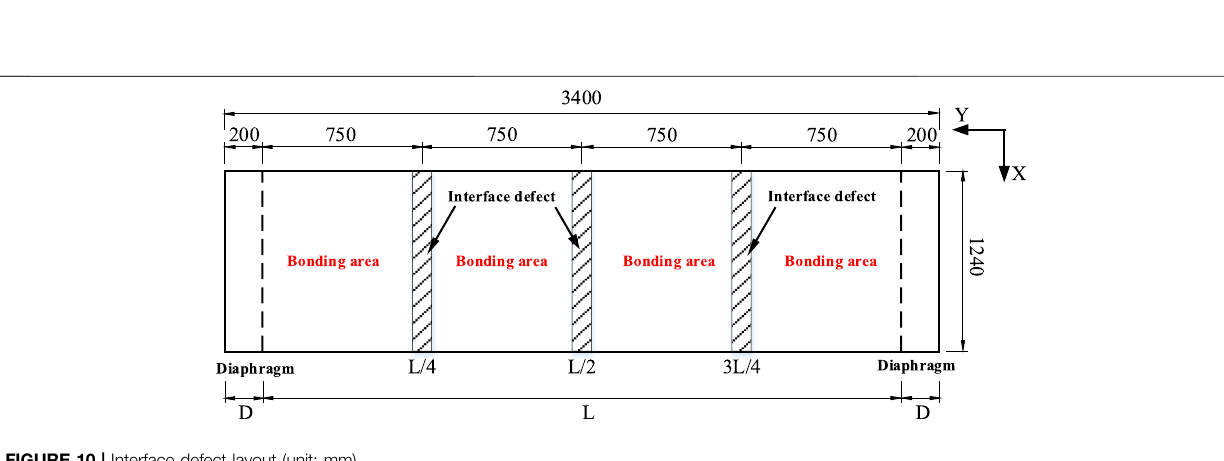
FIGURE 10 | Interface defect layout (unit: